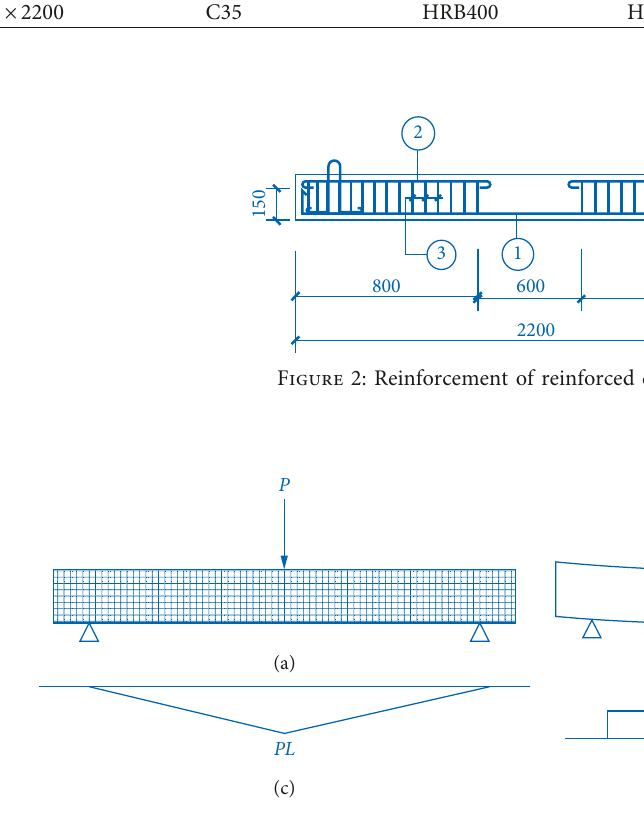
Figure 3: (a) Schematic diagram of loading of reinforced concrete beams. (b) Schematic diagram of loading and unloading of reinforced concrete beams. (c) Bending moment diagram. (d) Shear force diagram.